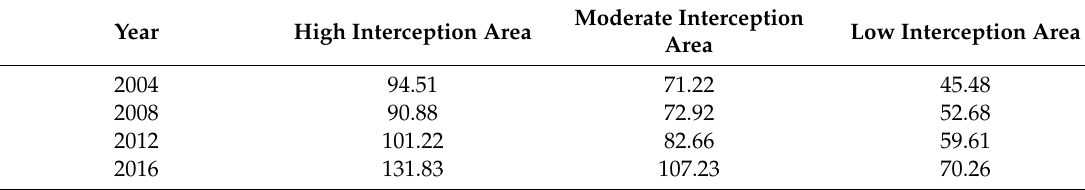
Figure 6. Spatial pattern of subregion with different rainfall interception in Guangdong in 2004. Table 2. Annual canopy rainfall interception (mm) in the different subregions.